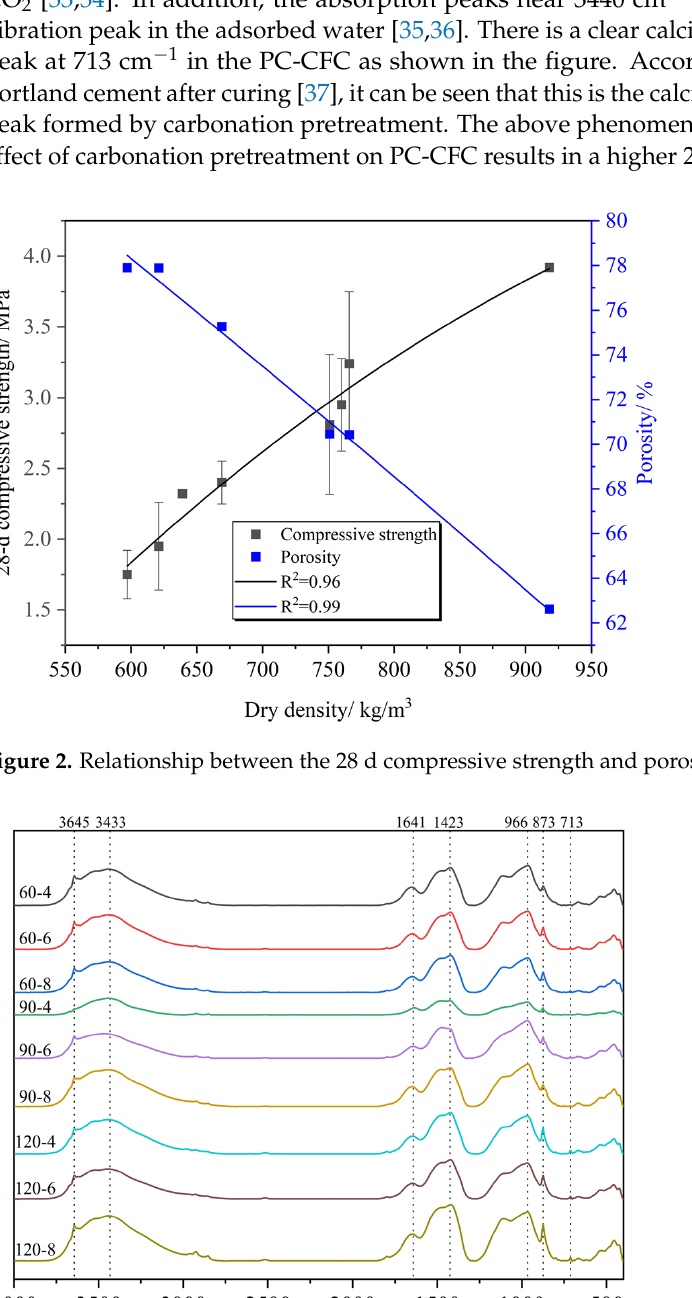
Table 4. Test results of PC-CFC.